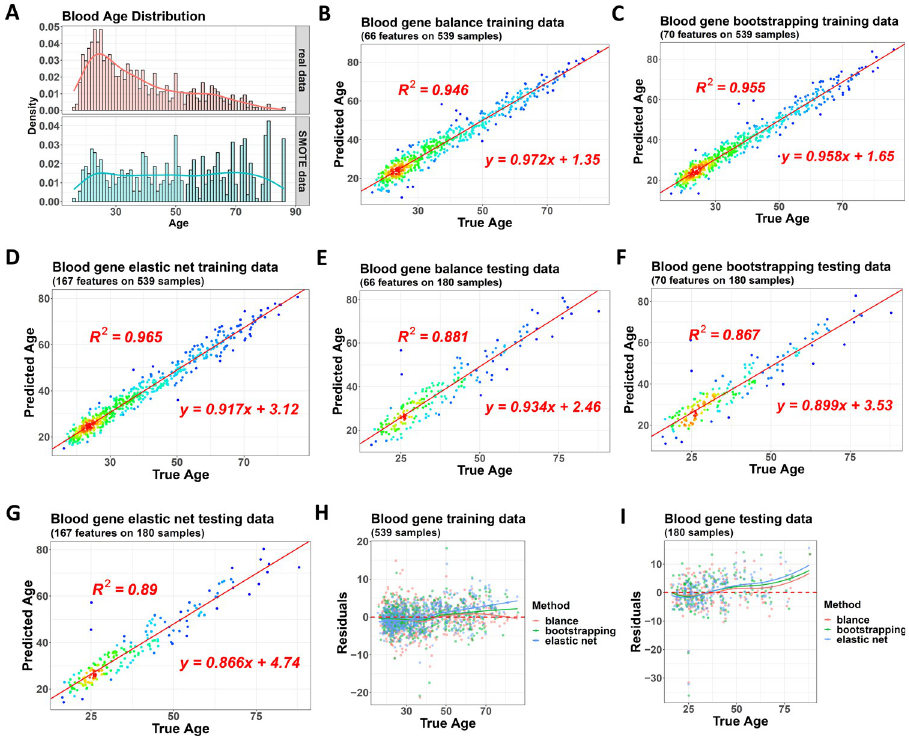
Fig 5. Performance of the three clock models on the whole blood dataset. (A) The original training dataset has a biased lifespan age distribution (upper). At the same time, the balanced clock model adjusts it to a balanced one (lower), with samples from all the 10 base learners combined and shown here, including synthesized samples from SMOTE and repeated samples due to bootstrapping and bagging. (B) to (D) Performance of the balanced model (B), bootstrapped model (C), and single normal model (D) on the same training dataset with genes as features. The color gradients of the dots indicate the density of the samples. (E) to (G) Performance of these three models on the same testing dataset with genes as features. (H) and (I) Residuals of the three models in training and testing datasets.